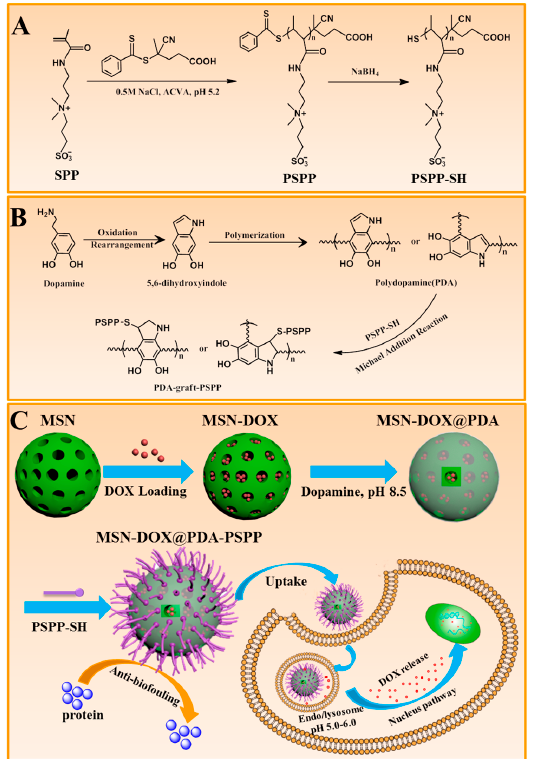
Figure 1. ( A ) Synthesis of